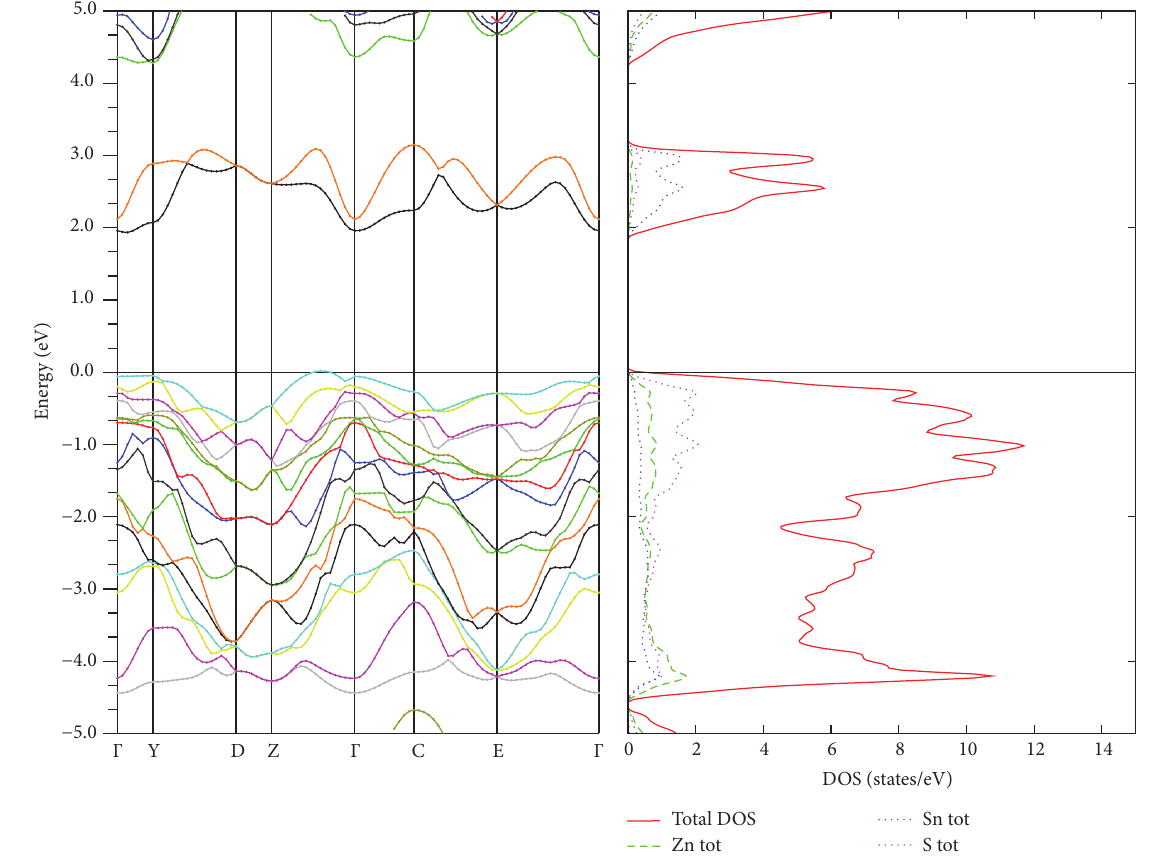
Figure 1: Energy bands in the monoclinic phase (space group number 4) of ZnSnS 3 , plotted along high symmetry directions, along with a plot of the density of states. The bands are calculated by using the mBJ potential for exchange and correlation. The zero of energy is taken to coincide with the valence band